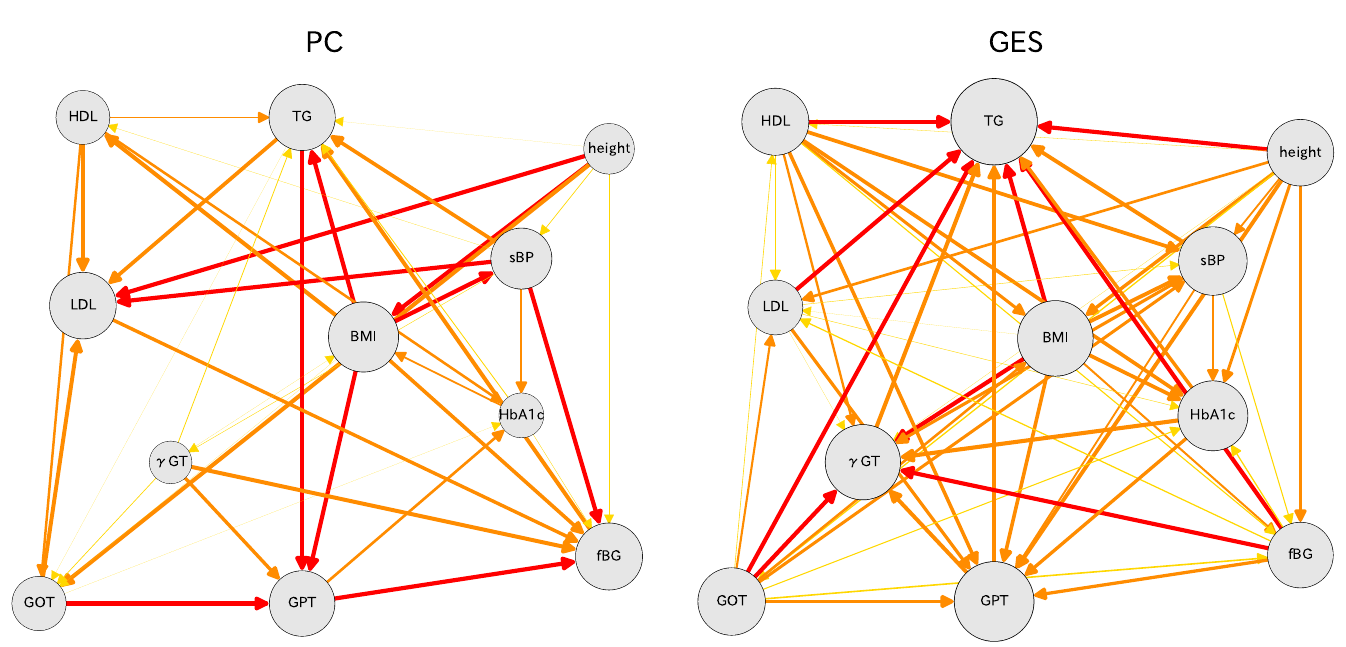
Fig 9. Causal diagrams for women in their 70s: PC (left) and GES (right) algorithms are used for these results.